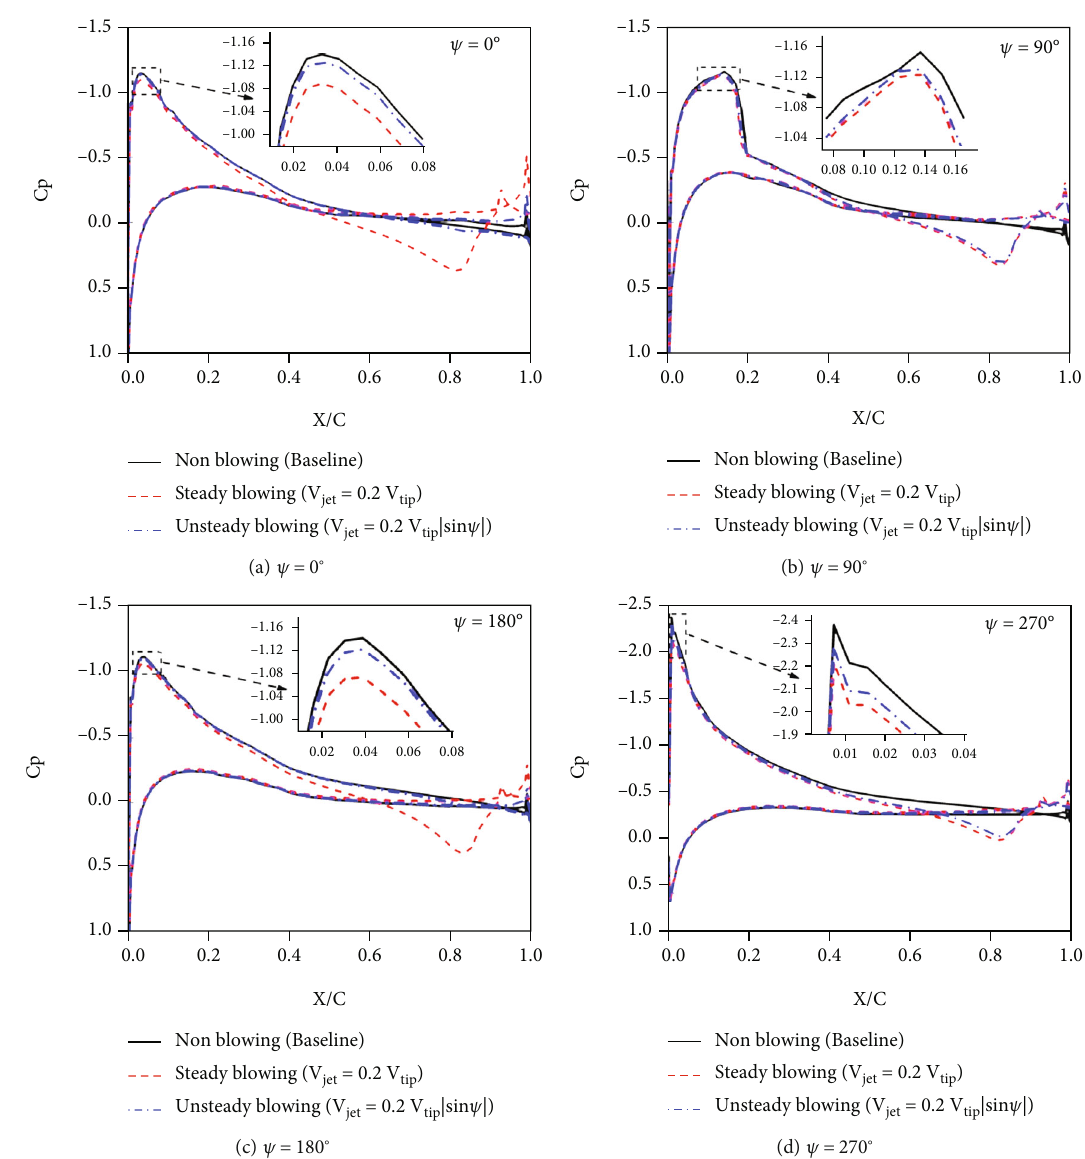
Figure 9: Blade surface pressure coe ffi cients ( r / R = 0 : 955 ) for the steady/unsteady blowing